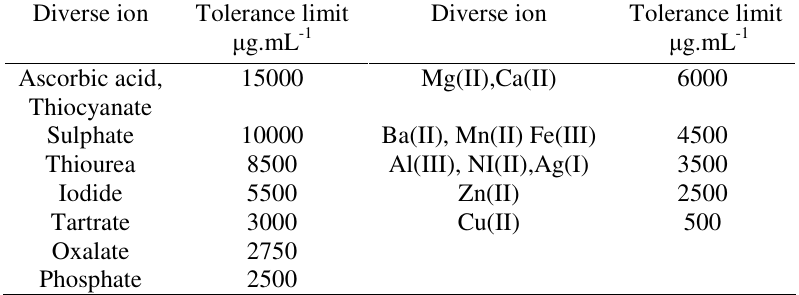
Table 1. Tolerance limit of diverse ions in the determination of Pd(II)